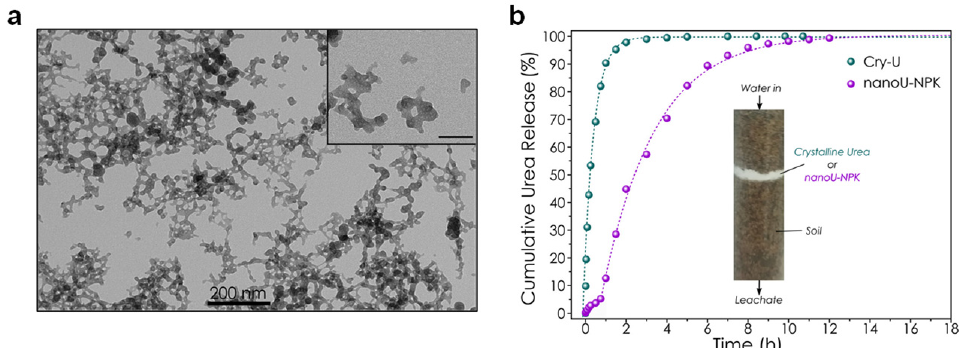
Figure 4. ( a ) TEM image of nanoU-NPK nanoparticles. ( b ) Cumulative urea release from granular urea (blue curve) and nanoU-NPK (magenta curve) embedded in a simulated solid medium, mim- icking an inert soil (a low-diffusive medium) during water irrigation. The inset shows a graphical representation of the column used in the leaching experiments “Reprinted with permission from Ref. [31]. 2020, ACS”.